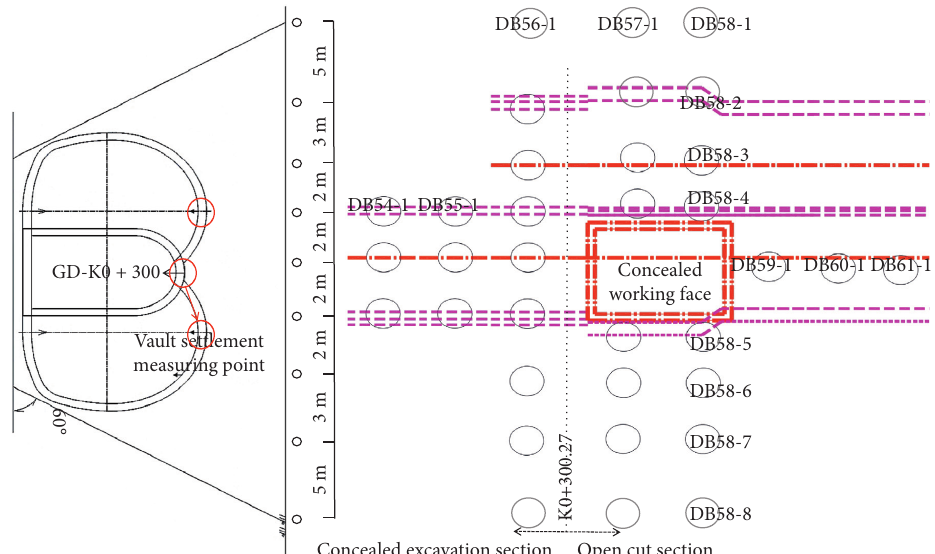
Figure 18: Layout of measuring points for land